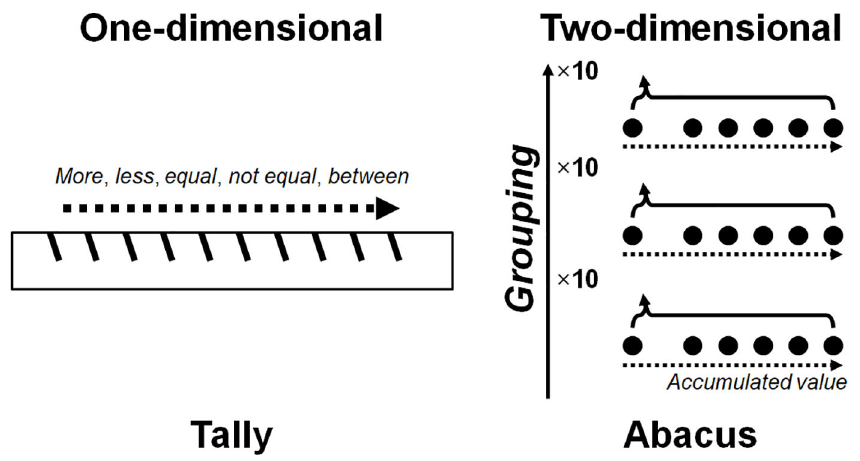
Figure 1. Exponential dimensions of counting devices. Note. Dimensionality is accumulation (a single, intra-exponential dimension) and grouping (a second, inter-exponential dimension). (Left) For material forms that accumulate but do not group, potential relations between numbers are those of an ordinal counting sequence (shown by the dashed line): more than , less than , same as , not the same as , between , and possibly one more . These intra-exponential relations are implicitly quantificational but not necessarily explicitly numerical (e.g., as a rosary can accumulate without number-words). Total value is achieved by accumulating along the single dimension. (Right) With material forms that also group, potential relations between numbers are those of the intra- exponential dimension (accumulation along the horizontal axis, shown by dashed lines) and those implicit to grouping (inter- exponential; accumulation along the vertical axis, shown by solid lines). Total value is achieved by accumulating along both dimensions. Western numbers have both dimensions (e.g., the numbers 0 through 9 and exponents 10 0 , 10 1 , 10 2 , etc.); Oksapmin numbers have the first (but perhaps not the second, depending on how one views repetitions of the cycle); and Mundurukú numbers have neither. Figures based on Chrisomalis